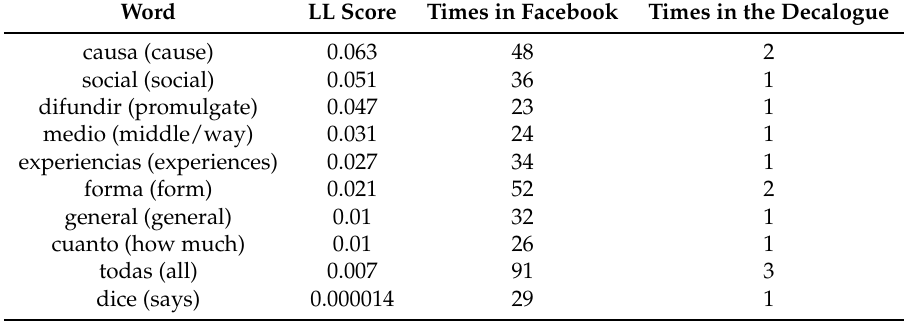
Table 4. Words with the lowest LL score.